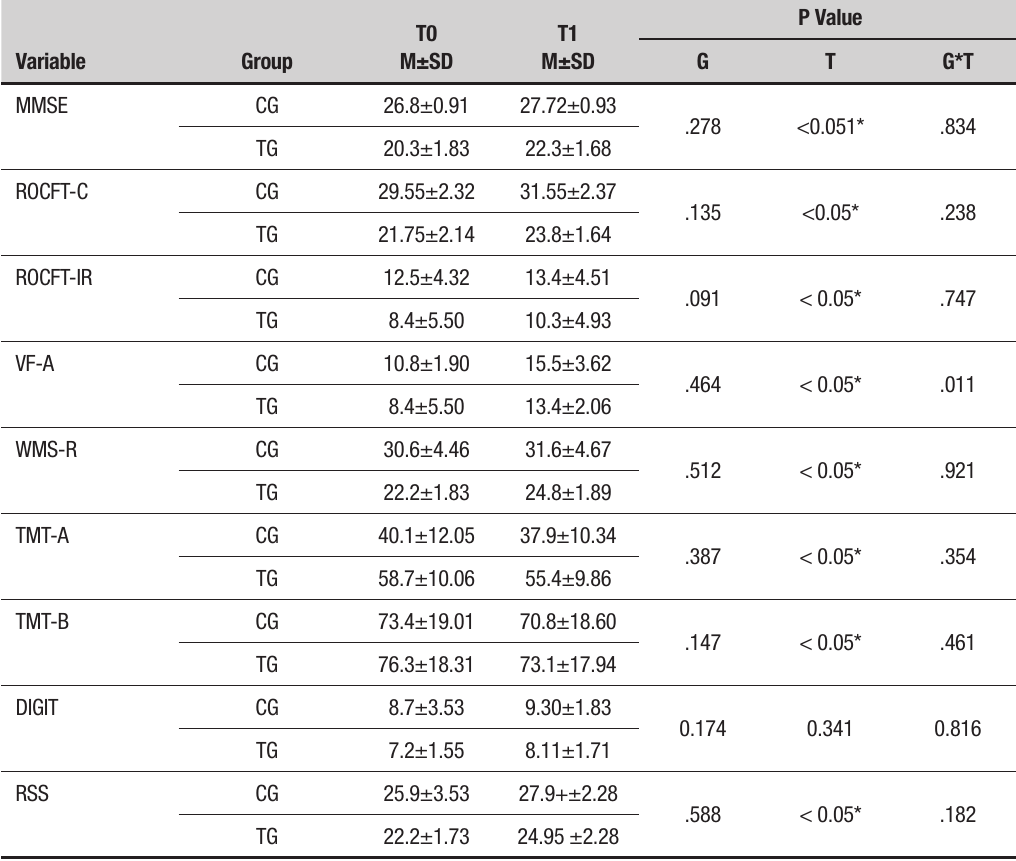
Table 3. Results of cognitive evaluation and RSS over time, by group effect, time, and group * time interaction.